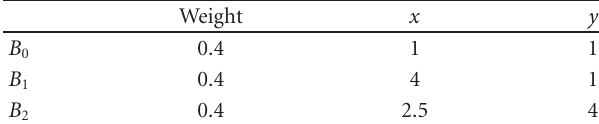
Table 2: An example of the signature B .